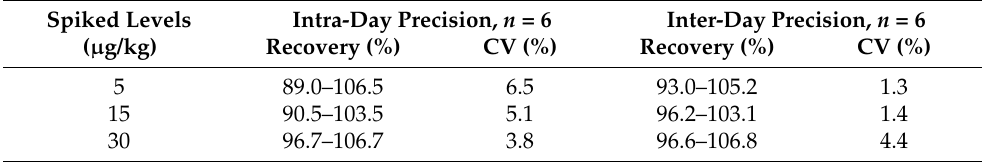
Table 3. Intra- and inter-day studies of AFB1 determination in distillers’ grain samples. Spiked Levels ( μ g/kg)